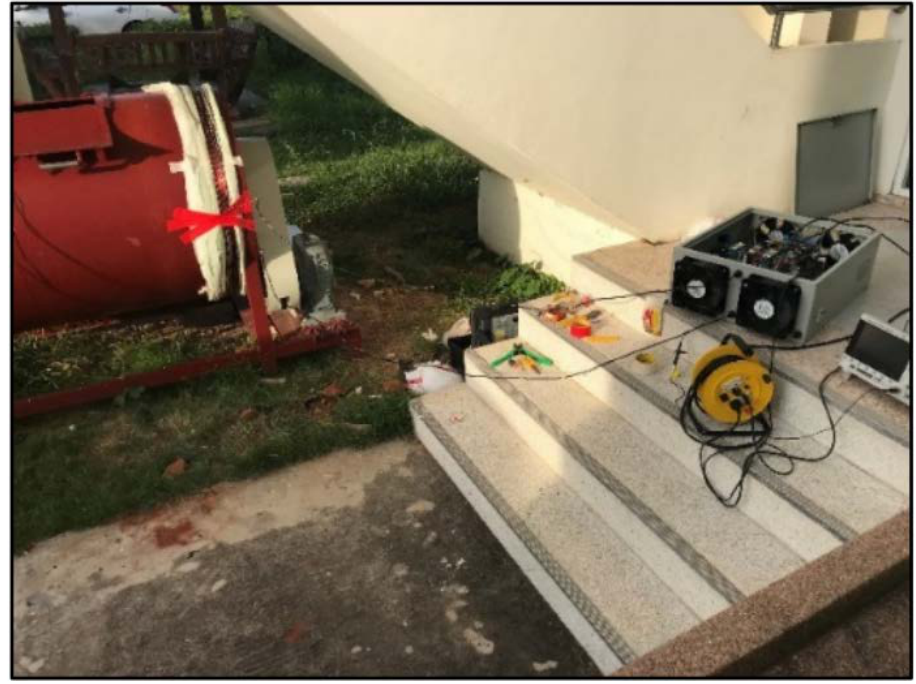
Figure 8. Heat induction machine applied to large bioreactor. After that, the temperature inside and outside the tank after 90 min was